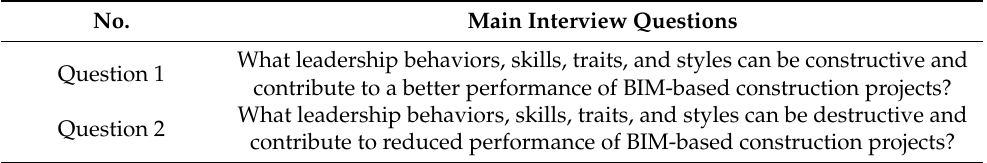
Table A1. The main questions for the open-ended interviews with AEC professionals involved in BIM-based construction